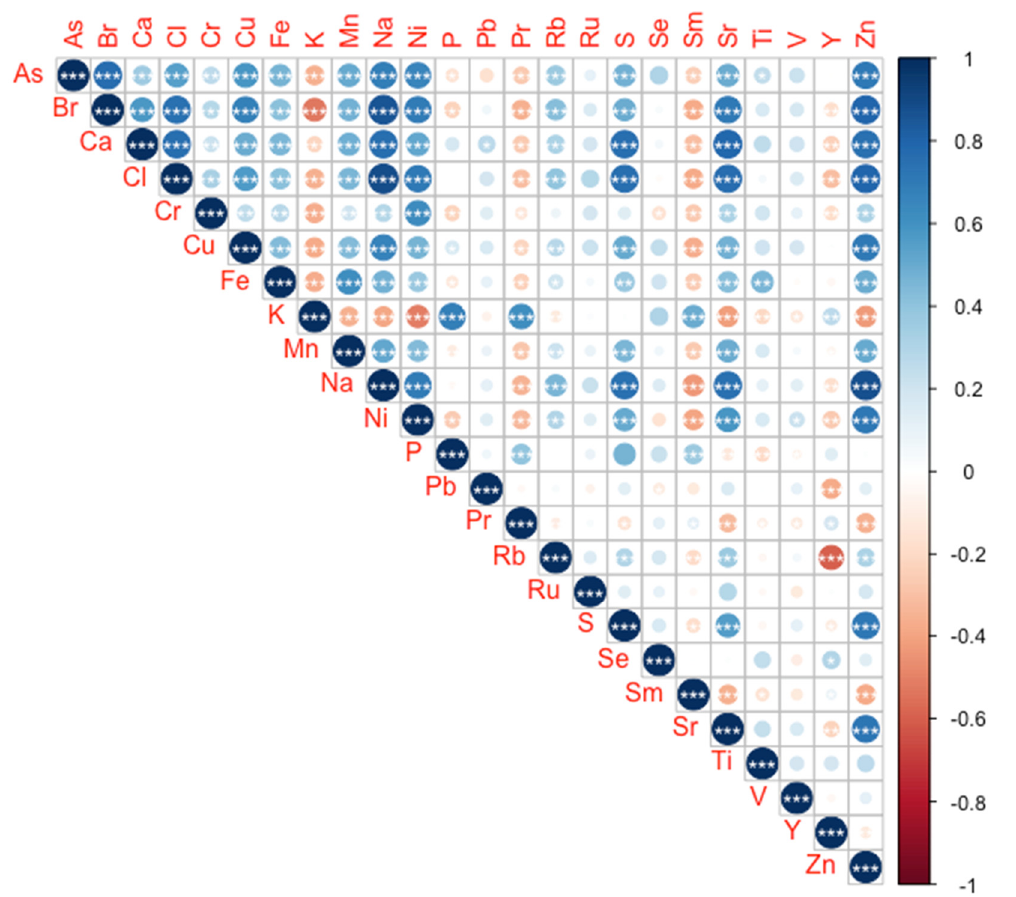
Figure 3 . Spearman correlation matrix heatmap ( ρ ) between the elemental concentrations detected in Pollicipes pollicipes peduncle (asterisks denote significant correlations at p < 0.05 *, p < 0.01 ** and p < 0.001 ***).